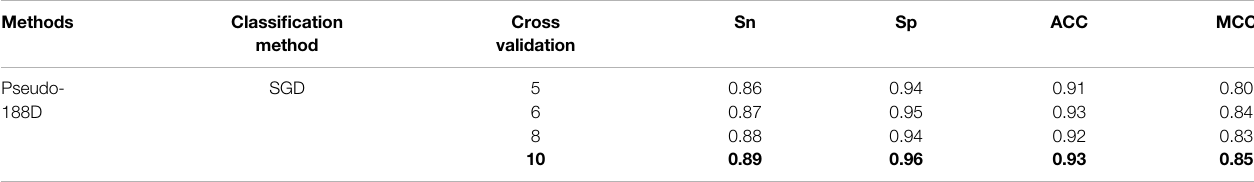
TABLE 3 | Performance comparison of Pseudo-188D models under different cross-validations.